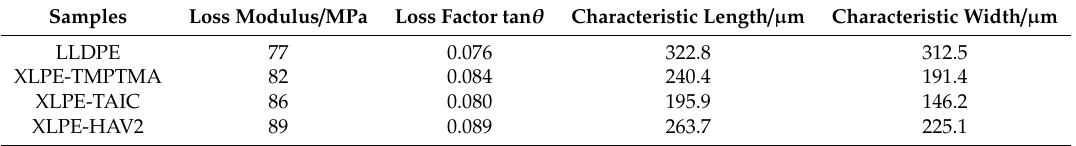
Table 2. Water-tree dimension and β relaxation parameter.